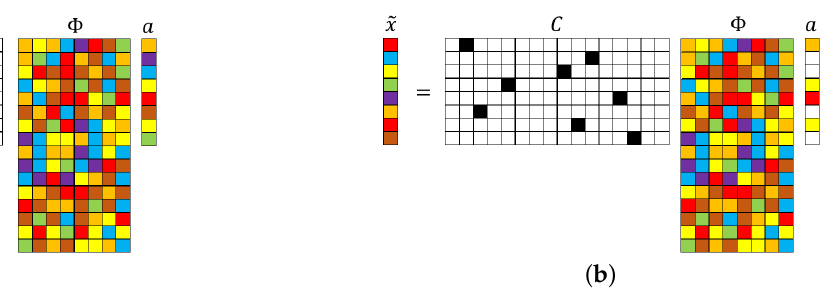
Figure 1. Schematic illustration of l 2 ( a ) and l 1 ( b ) minimization reconstruction for sparse recovery using a single-pixel measurement matrix. The numerical values in C are represented by colors: black (1) and white (0). The other colors represent numbers that are neither 0 nor 1. In the above schematics, ˜ x ∈ R P , C ∈ R P × N , Φ ∈ R N × N b and a ∈ R N b , where N b ≤ N . The number of colored cells in a represents the system sparsity K . We note that, for K = N b , the method of choice is l 2 and, for K smaller than N b , the method of choice is l 1